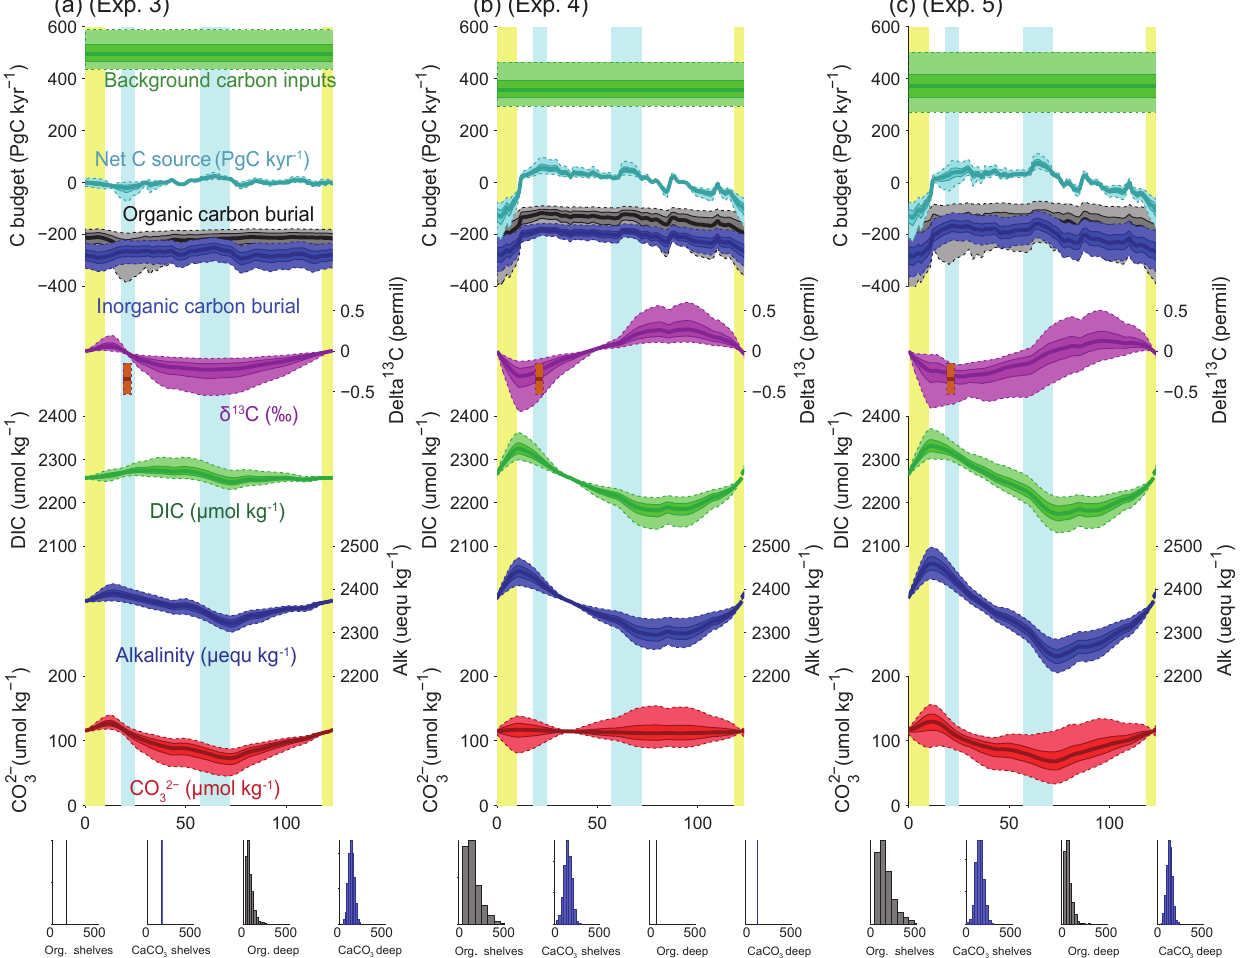
Figure 8. Simulated impacts of deep and shelf burial fluxes on carbon and alkalinity inventories: (a) variable deep-sea burial (carbonate plus C org ), (b) variable shelf burial, and (c) variable total marine burial (deep plus shelf). All quantities and bars are plotted as in Fig.